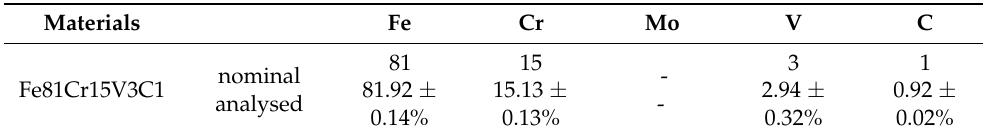
Table 1. Nominal and real chemical composition (in wt%) of the novel cast steel with relative standard deviation (RSD in